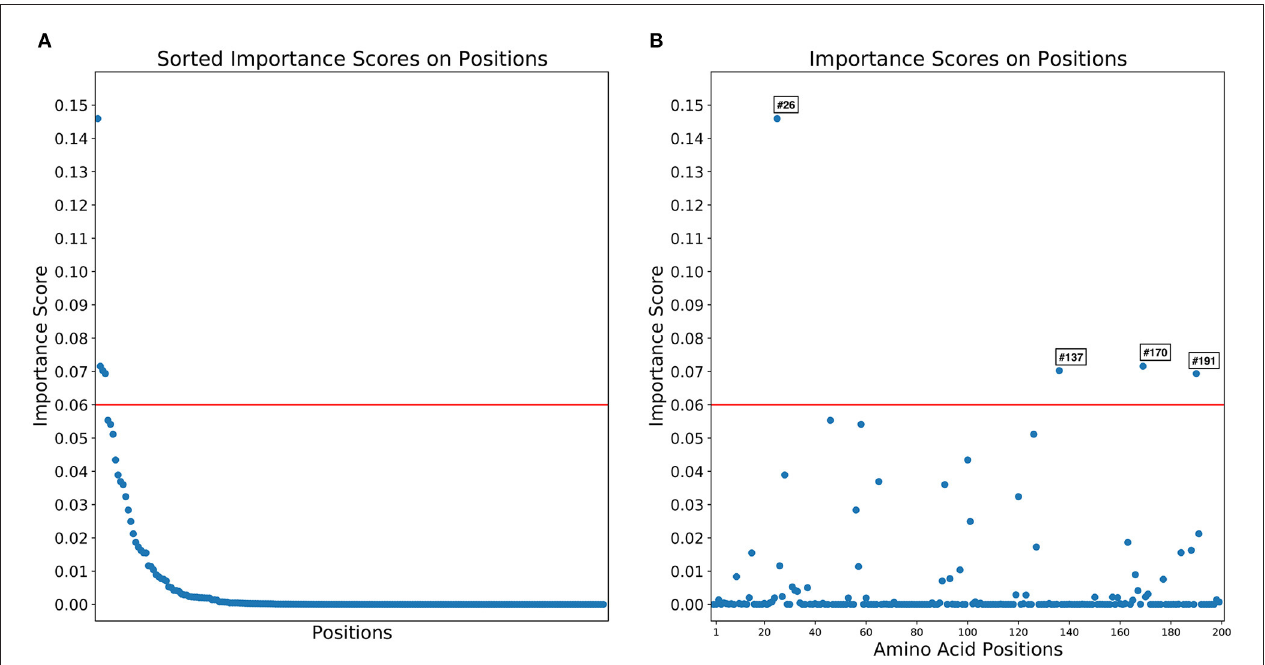
Amino acid in L5 clade (%) ( n = 438)